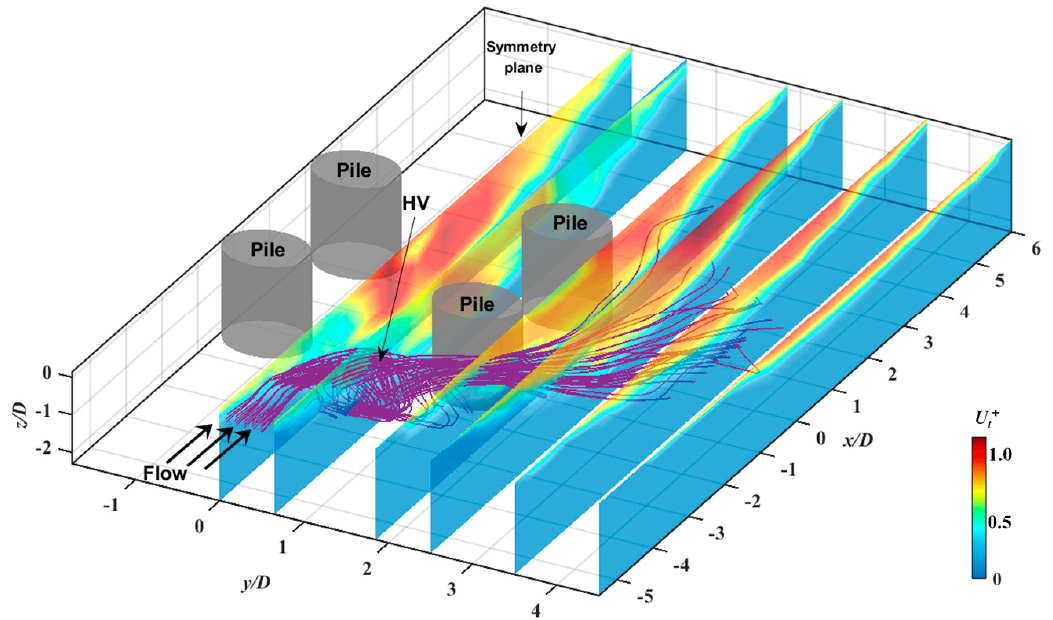
Figure 13. Three-dimensional streamline and contours of the total velocity at different longitudinal sections within the equilibrium scour hole.